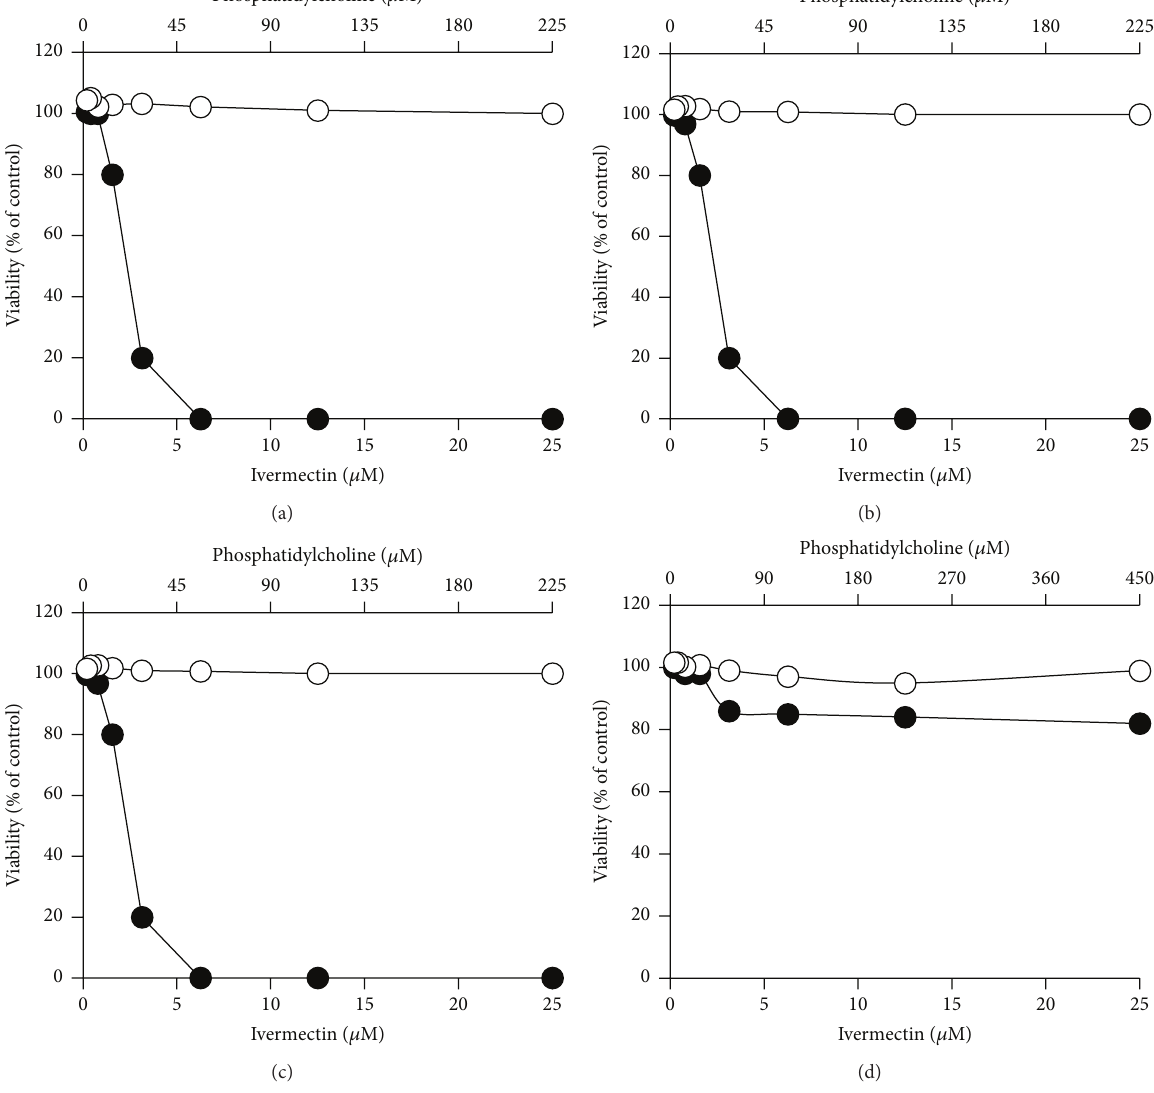
Figure 10: In vitro cytotoxicity effect of ivermectin formulated in liposomes (closed circles) on RAW cells. For comparison the same experiments were performed using empty liposomal formulations (open circles). The following liposomal formulations were tested: #PC9- Ch1 and #PC9-Ch1-ive1.0 (a), #PC9-Br1 and #PC9-Br1-ive1.0 (b), #PC9-Br0.5 and #PC9-Br0.5-ive1.0 (c), and #PC18-Br1 and #PC18-Br1-ive1.0 (d). The phosphatidylcholine concentration (top 𝑥 -axis) is related to empty liposomes while the ivermectin concentration (bottom 𝑥 -axis) is related to ivermectin liposomes. Details on the identification codes and liposomal compositions are included in Table 1. Data represent the average of 2